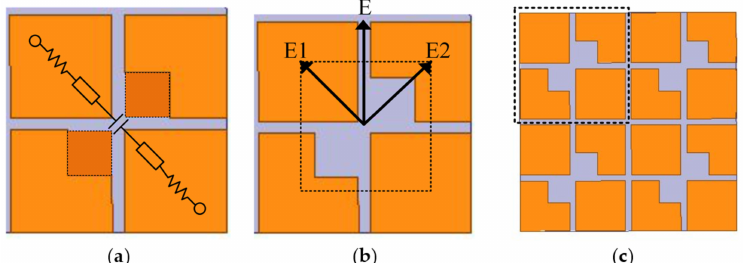
Figure 3. The mechanism of generating circularly polarized waves from linearly polarized waves for the corner-cut square metasurface ( a ) an equivalent circuit of the metasurface unit cell; ( b ) an electric field distribution of the metasurface unit cell; ( c ) the basic